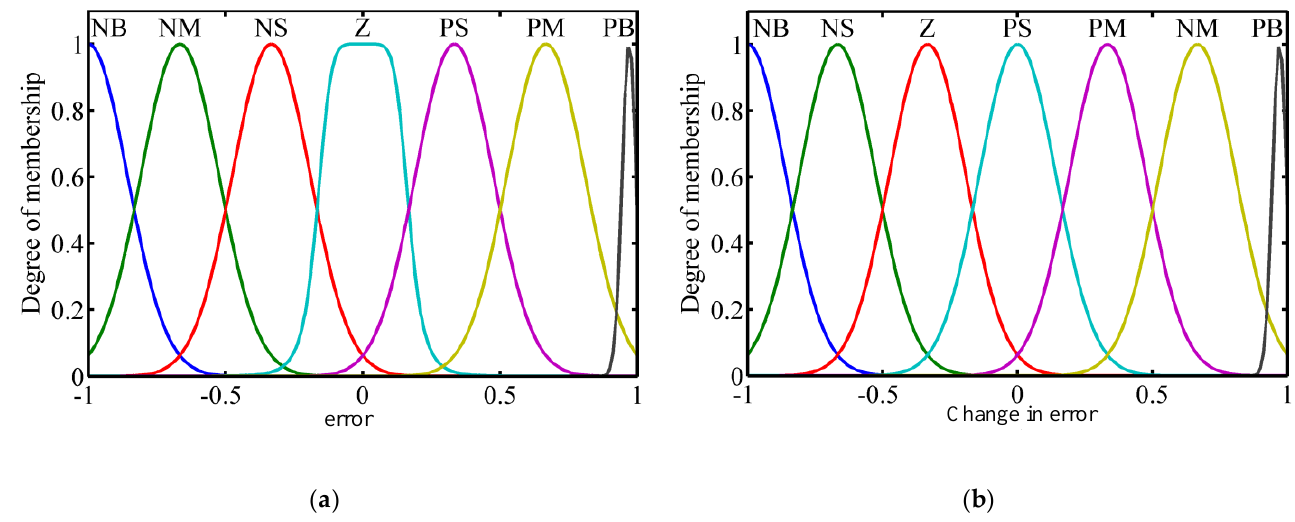
Figure 4. Sugeno method FLC structure with membership functions. ( a ) Error in voltage (e), ( b ) change in error voltage (ce).